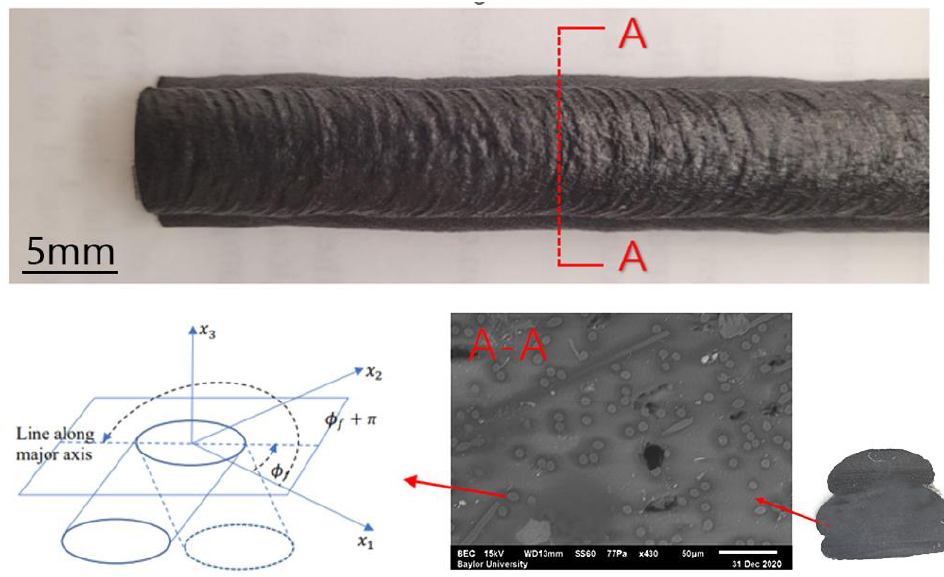
Figure 4. Fiber orientation measurement on an LAAM-deposited bead with MoE [92].